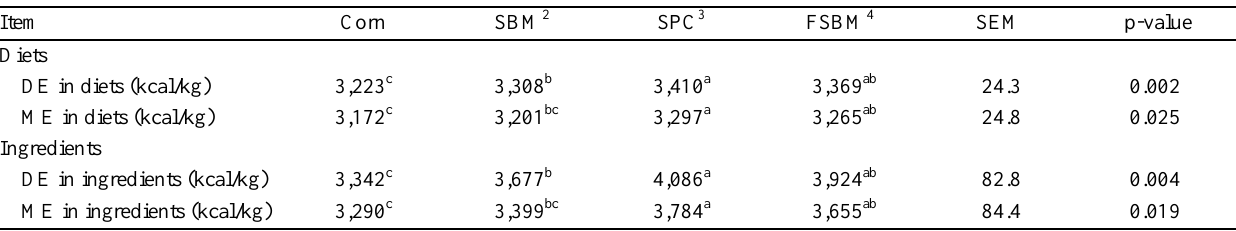
Table 5. The DE and ME contents in diets and ingredients (as-fed basis), Exp. 1 1 Item